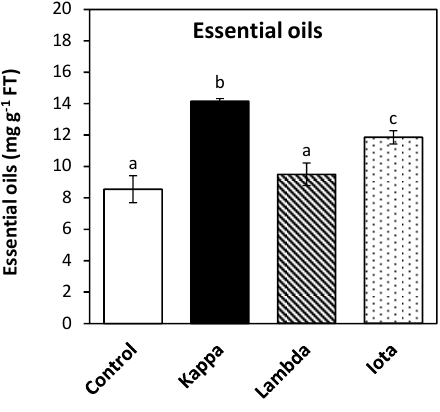
Figure 3. Content of total essential oils in leaves of control Eucalyptus (control) and in trees treated with oligo-carrageenans (OCs) kappa, lambda and iota. The amount of essential oils is expressed as milligram per gram of fresh tissue